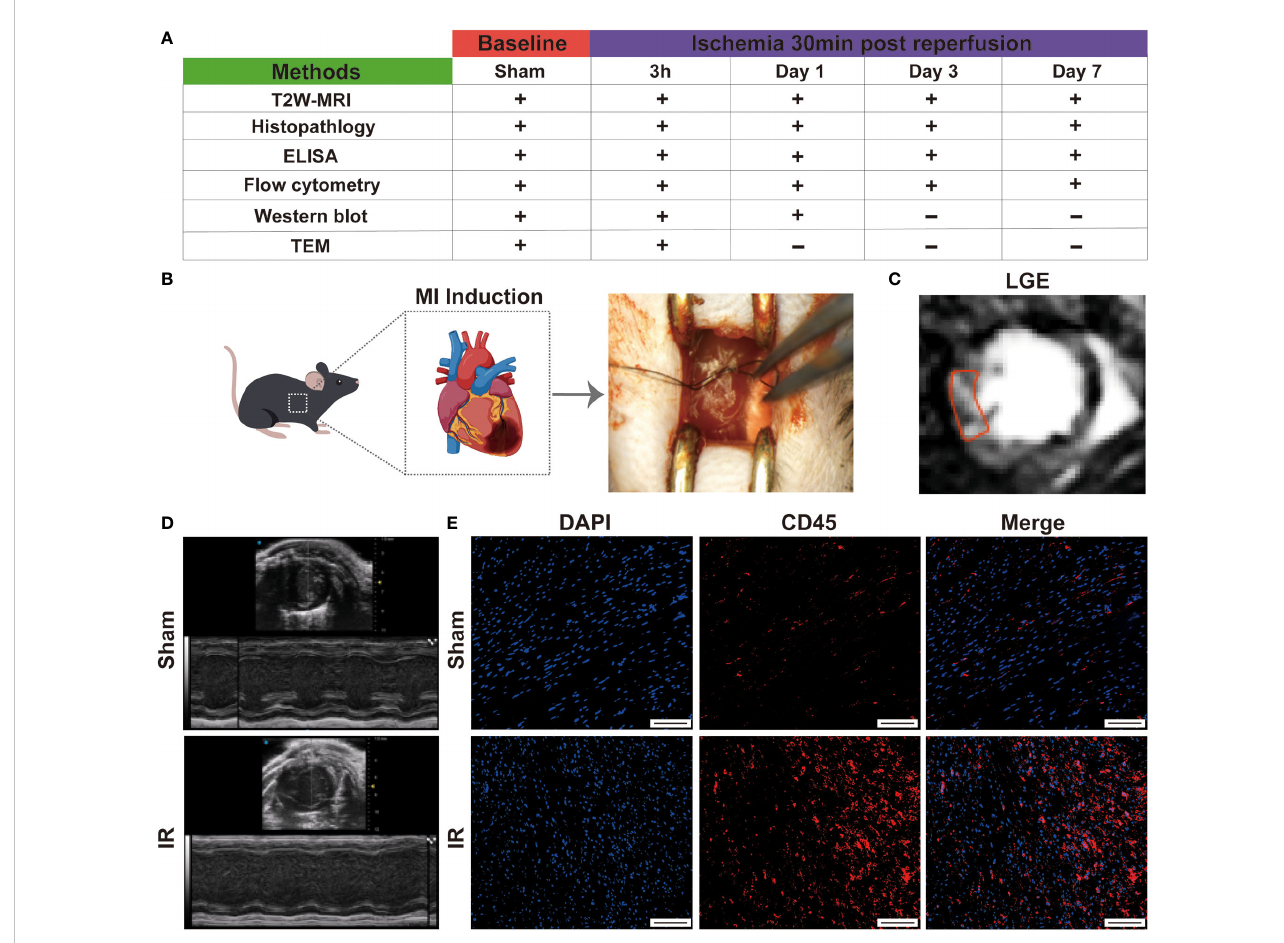
FIGURE 1 Establishment of mouse IR model. (A) , schema of in vivo protocol. The present study population comprised 60 mice which were used for the characterization of myocardial in fl ammation during the fi rst week after IR. (B) , graphic image of myocardial IR injury induction. (C) , typical LGE image on day 7 in IR group. (D) , representative echocardiography on day 1 in sham and experimental group. (E) , immuno fl uorescence staining detect the in fi ltration of leukocytes (Bar=150 m